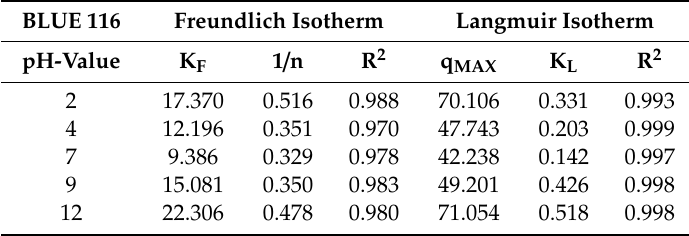
Figure 7. Adsorption isotherm for Reactive Yellow 81 at different pH values. Table 5. Return of adsorption isotherm data for Reactive Blue